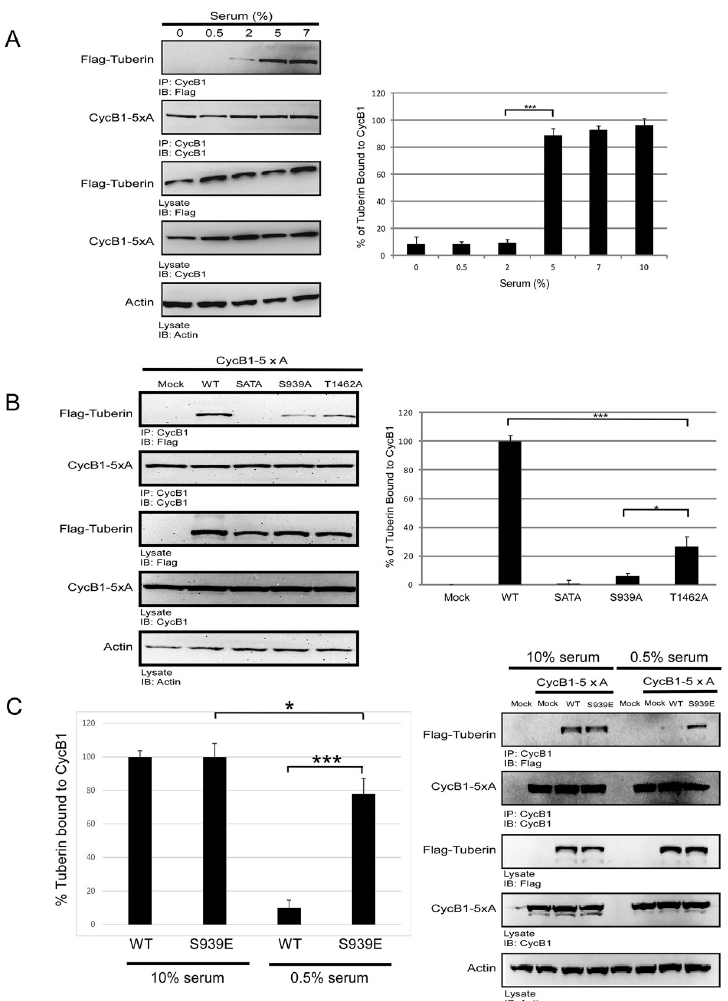
Fig 1. TSC2-CycB1 interaction is serum and Akt phosphorylation dependent. (A) HEK293 cells were transfected with Flag-TSC2 and CycB1-5xA. 18 hrs post-transfection, cells were washed with PBS and incubated for 2 hrs with different concentrations of serum (indicated as % serum). Cell lysates were subjected to IP using CycB1 antibody Representative blots; left panel. Densitometry analysis was conducted measuring the % of Tuberin bound to CycB1 (CycB1 � 100/Tuberin densitometry values; Y-axis) (right panel). Errors represent SD over 3 separate transfections. Unpaired t-test, ��� p < 0.001. (B) HEK293 cells were transfected with CycB1-5xA and either pCMV-Mock control, Flag-WT-TSC2, Flag-TSC2-SATA, Flag-TSC2 S939A or Flag-TSC2 T1462. 18 hrs post-transfection cells were lysed and subjected to IP using CycB1 antibody. Representative immunoblots are shown (left panel). Densitometry analysis was conducted measuring the % of Tuberin bound to CycB1 (CycB1 � 100/Tuberin densitometry values; Y-axis) (right panel). Errors represent SD over 3 separate transfections. Unpaired t-test, � p < 0.05 and ��� p < 0.001. ( C ) HEK293 cells were transfected with CycB1-5xA and either pCMV-Mock control, Flag-WT-TSC2 or Flag-TSC2-S939E. 18 hrs post-transfection cells the cells were incubated with 10% or 0.5% serum, 2 hrs after the cells were lysed and subjected to IP using CycB1 antibody. Representative immunoblots are shown (left panel). Densitometry analysis was conducted measuring the % of Tuberin bound to CycB1 (CycB1 � 100/Tuberin densitometry values; Y-axis) (right panel). Errors represent SD over 3 separate transfections. Unpaired t-test, � p < 0.05 and ��� p <